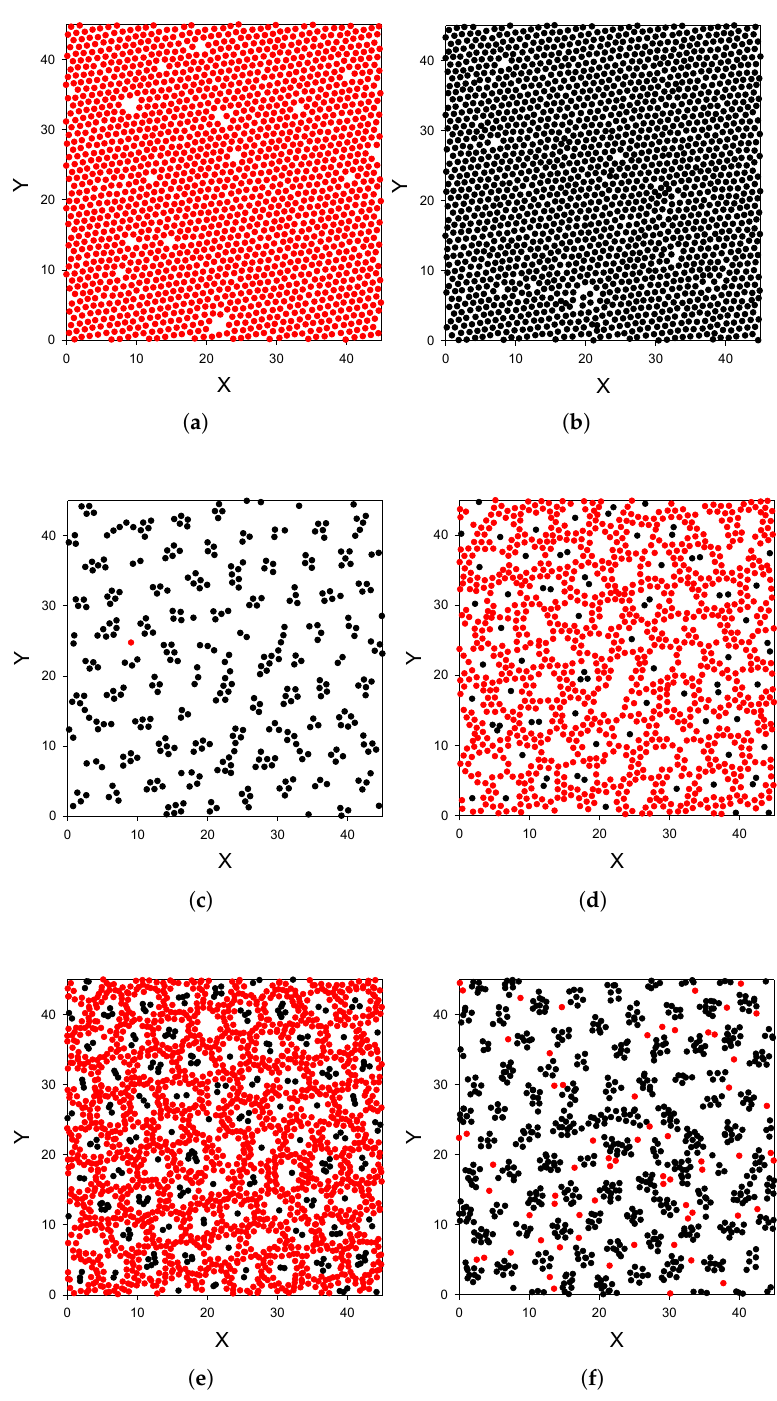
Figure 4. Distribution of the particles near a surface strongly attracting the first, and moderately repelling the second component. In panels ( a – d ) projections on the ( x , y ) plane of the particles in the monolayers 0.9 < z < 1.5, 2.3 < z < 3.3, 3.3 < z < 4.0 and 4.0 < z < 5.0 are shown for a representative configuration. Almost no particles are present for 1.5 < z < 2.3, i.e., between panels ( a , b ). In panels ( e , f ), projections of particles in double layers of thickness ∼ 2, with 4.0 < z < 5.9 and 5.9 < z < 8, respectively, are shown. By comparing ( d , e ), one can see the particle distribution in